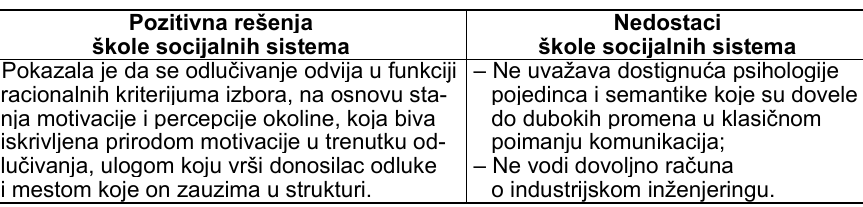
Škola društvenih sistema – doprinosi i nedostaci Social systems school – merits and shortcomings